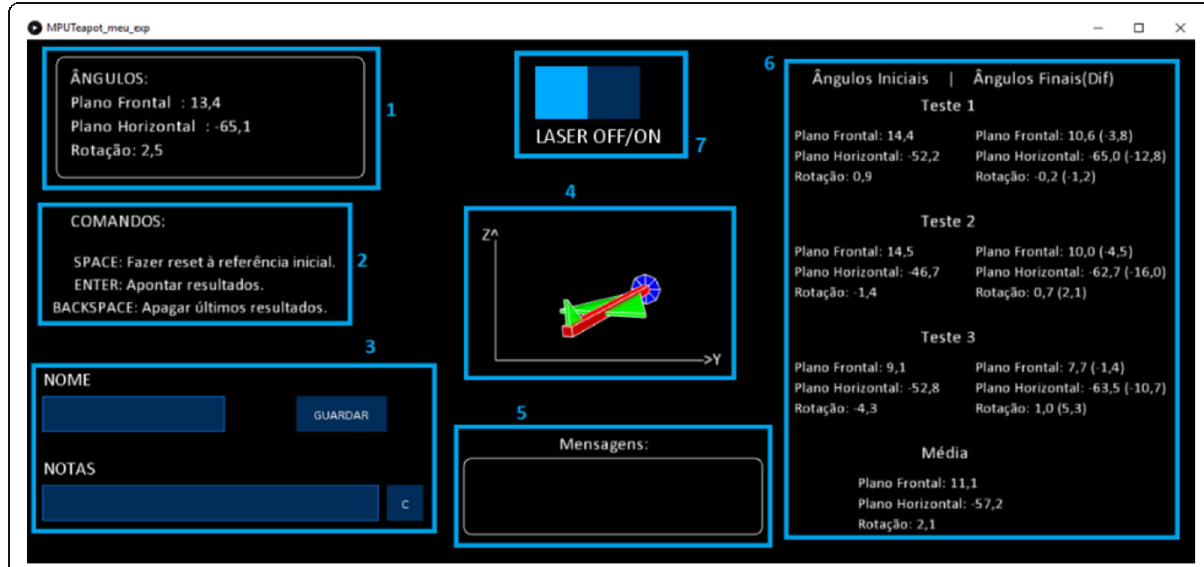
Fig. 3 Software user interface. This layout is a computer screenshot during the experimental setting. Gyroscopes and accelerometers are used in commercial aviation and work like a 3-dimensional compass, showing the position of the airplane relative to the ground. For this reason the Figure in the centre of the screen, which represents the foot position, is displayed as an airplane. On the upper left box, “ Ângulos ” stands for angles; “ Plano Frontal ” refers to the coronal plane measurement; “ Plano Horizontal ” refers to the sagittal plane measurement and “ Rotação ” refers to the axial